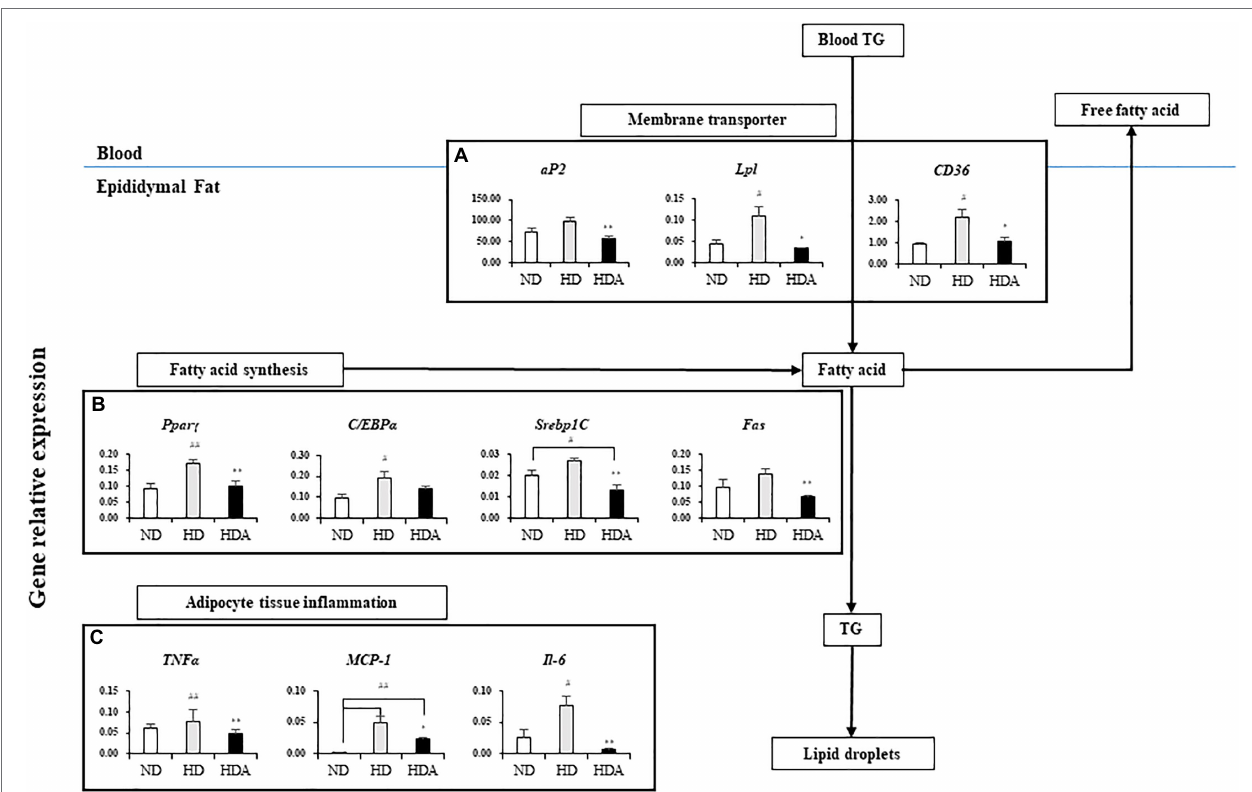
FIGURE 2 | Effects of administering L. sakei ADM14 on the transcription of genes related to lipid metabolism in epididymal fat tissue. The results are shown as mean ± SEM ( n = 5). Significant differences between HD and ND are indicated as # p < 0.05 and ## p < 0.01. Significant differences between HDA and ND are indicated as # p < 0.05 and ## p < 0.01. Significant differences between HD and HDA are indicated as * p < 0.05 and ** p <